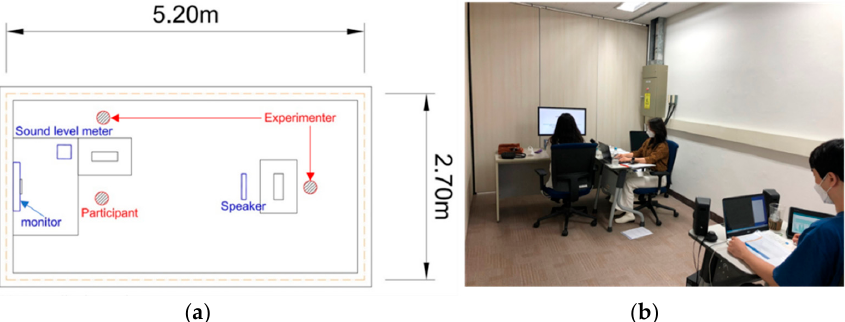
Figure 3. Experimental environment: ( a ) data collection environment, ( b ) laboratory environment and